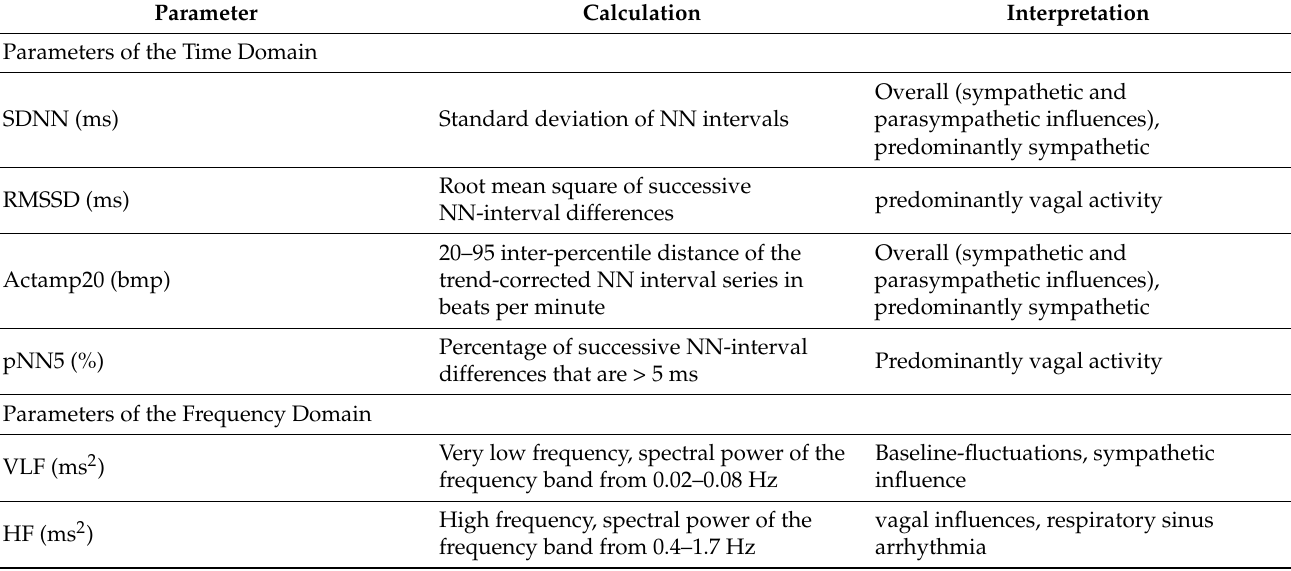
Table 1. Selected parameters of beat-to-beat heart rate variability